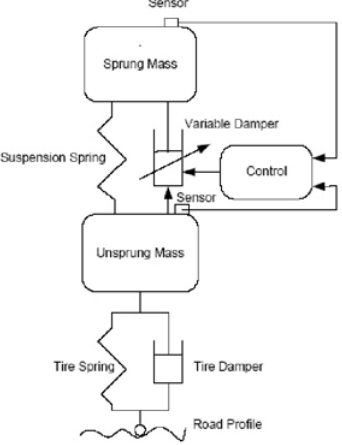
Figure 2. Dynamic model for Quarter